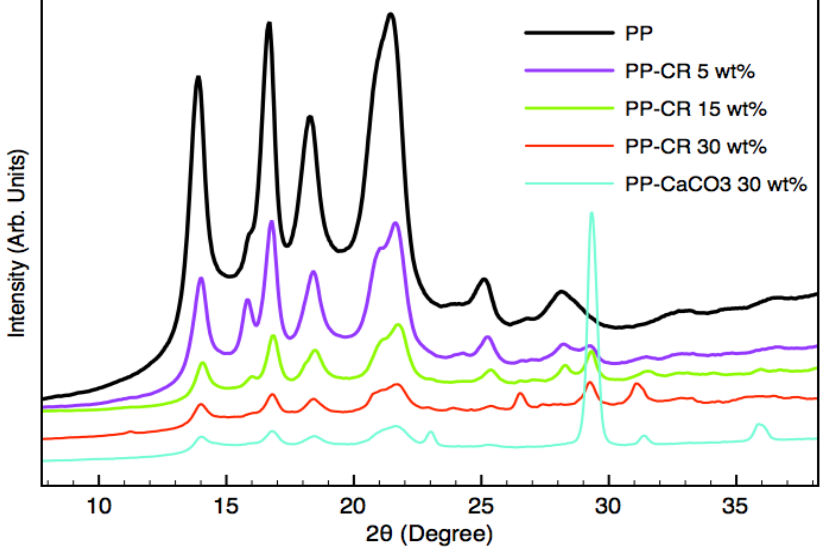
Figure 3. Diffraction patterns collected from polypropylene (PP), PP-CaCO PP-CR